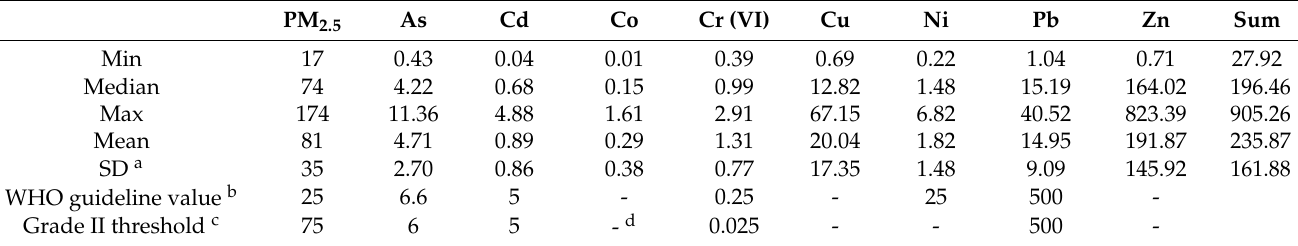
Table 2. Statistical description of the daily PM 2.5 mass ( µ g · m − 3 ) and the concentrations of